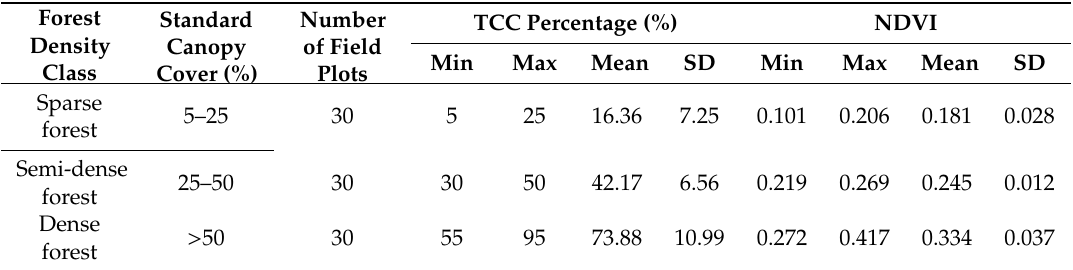
Table 7. Details of normalized di ff erence vegetation index (NDVI) and tree canopy cover (TCC)% obtained from field plots for each forest density